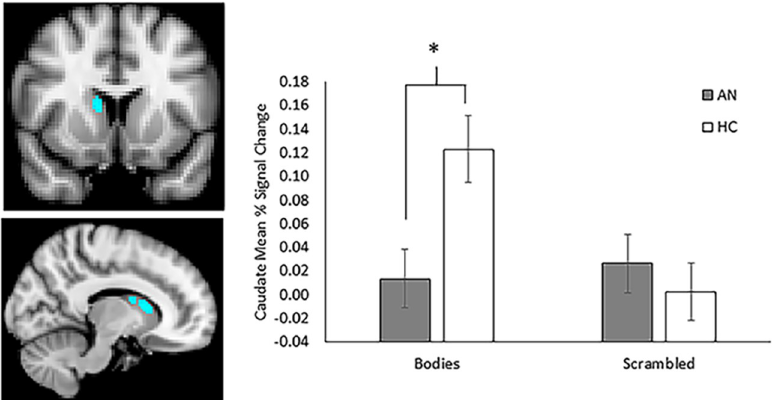
Fig 3. Group contrast comparing activation of bodies relative to scrambled images. Control participants demonstrated increased activation in the right caudate relative to participants with a history of anorexia who were weight restored when viewing whole body images relative to scrambled images. Blocks of body images where collapsed across weight and attractiveness categories. Slices are shown at Y = 10 (top left) and X = 10 (bottom left). Mean percent BOLD signal change extracted from functional cluster in the right caudate for bodies and scrambled images, plotted against group (right panel). Control participants exhibited significantly increased activation to bodies relative to those with history of anorexia, whereas activation to scrambled images did not differ between groups. Error bars represent standard error of the